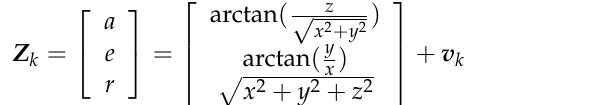
Y Z O μ λ R Figure 3. The geocentric coordinate system and reference coordinate system of the radar station. The radar position R is the origin of the coordinate system, and the RE , RN , and RU axes point to the east, north, and sky directions perpendicular to each other.